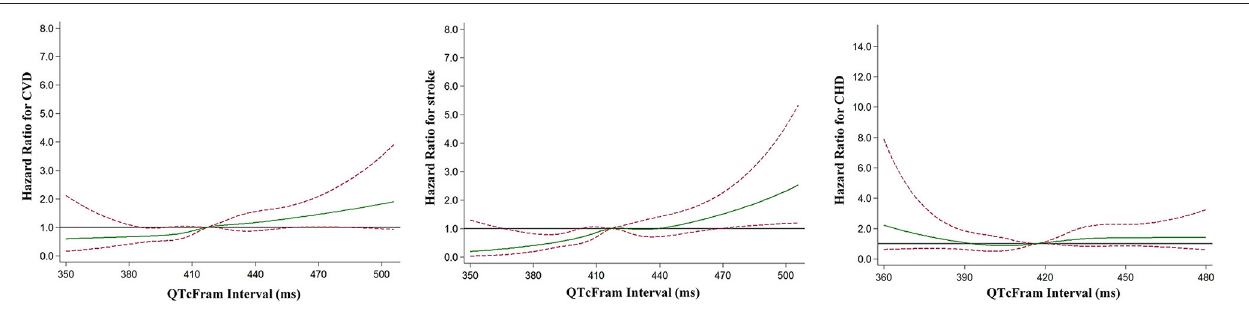
Frontiers in Cardiovascular Medicine |